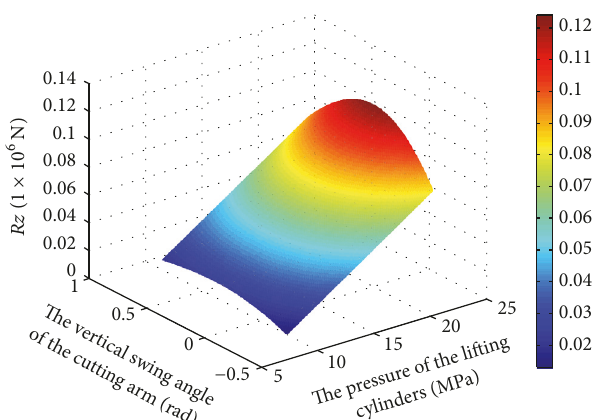
Figure 8: The component force 𝑅 𝑍 of the cutting head load in the vertical direction.